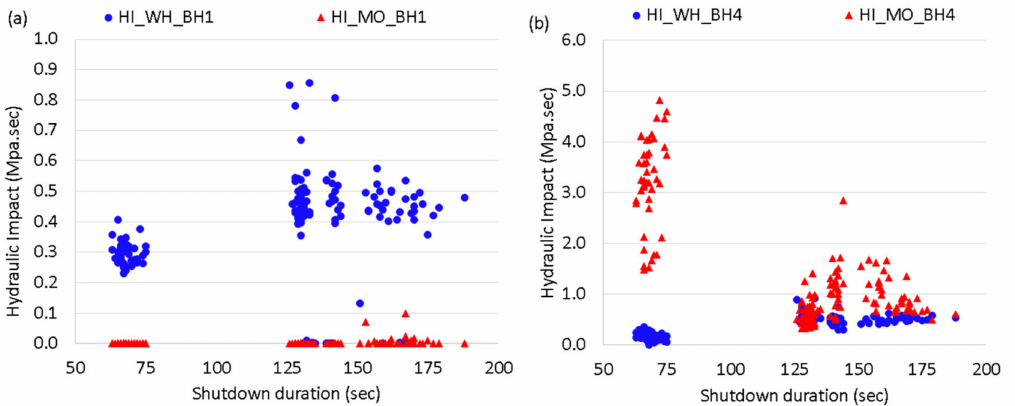
Figure 12. Effect of shutdown duration on hydraulic impact ( a ) for BH1 and for BH4 ( b